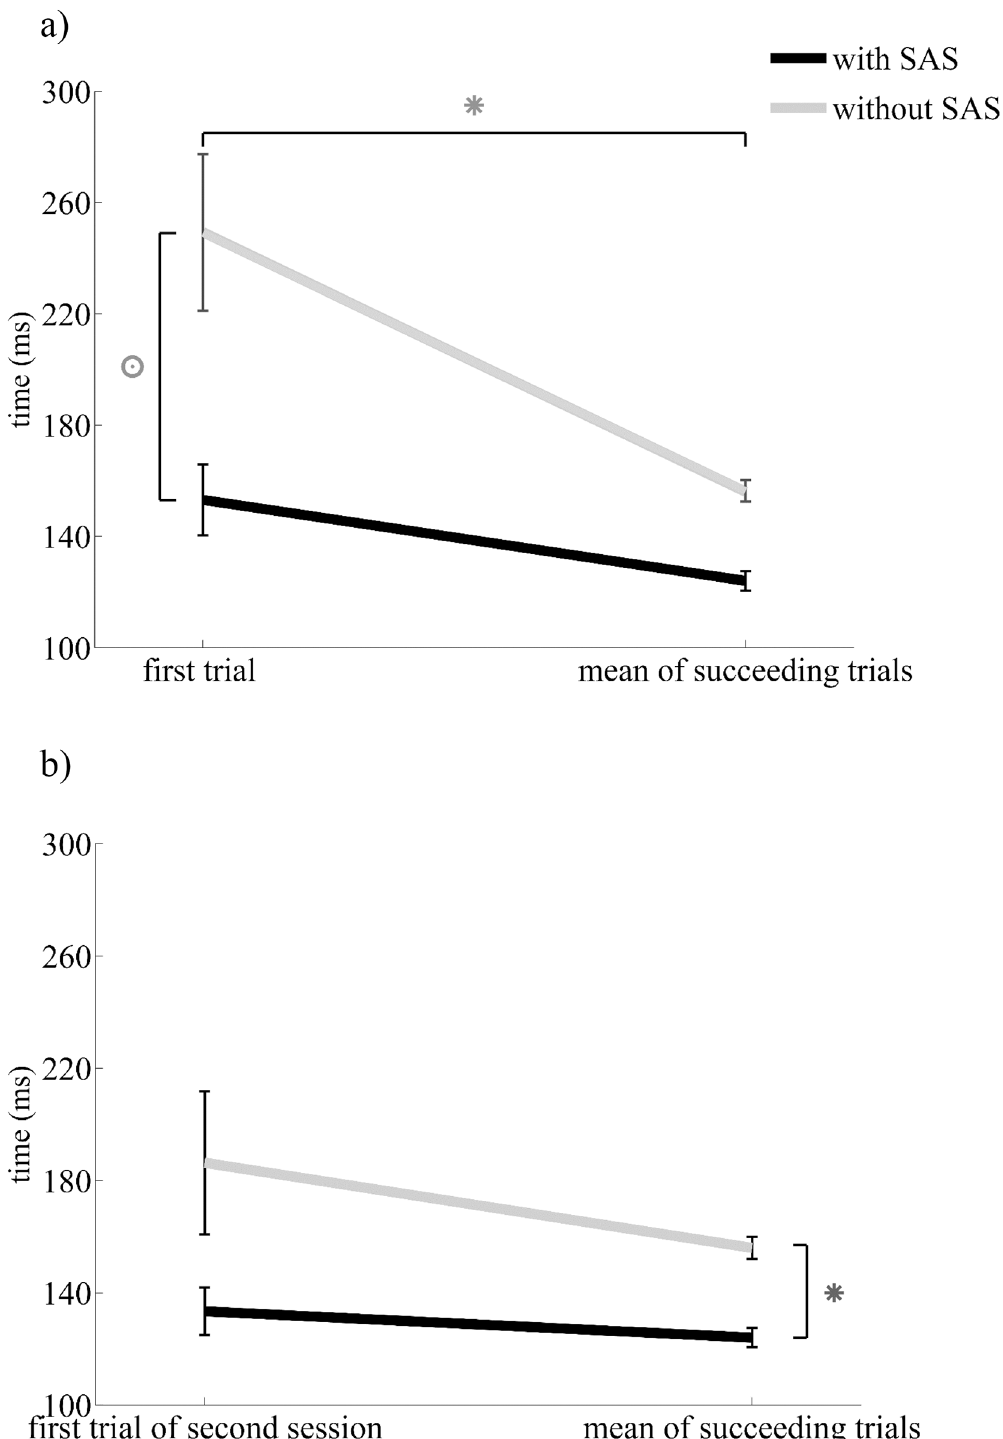
Fig 3. a) Mean onset latencies of tibialis anterior muscle during the simple reaction time task with voluntary ankle dorsiflexion in first trial of first session and the succeeding trials. * Significant differences between first trials and mean of succeeding trials. ס Significant SASxGroup interaction. b) Mean onset latencies of tibialis anterior muscle during the simple reaction time task with voluntary ankle dorsiflexion in succeeding trials of first session and the first trial of second session. * Significant main effect of SAS.